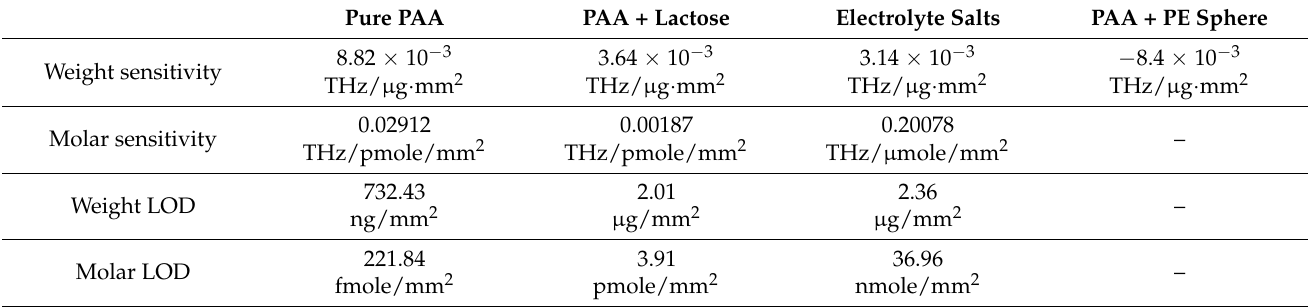
Table 2. 90 µ m W MCWM sensitivity and LOD for sensing different kinds of analytes. Pure PAA PAA + Lactose Electrolyte Salts PAA + PE Sphere Weight